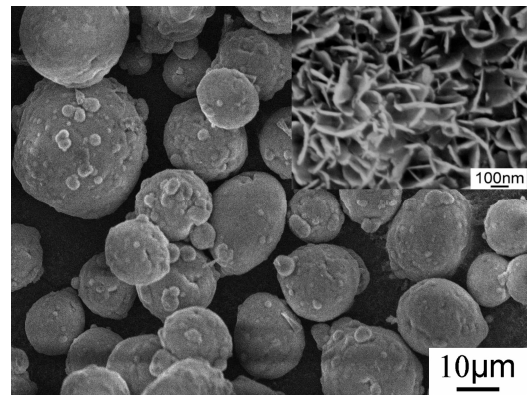
Figure 4. SEM image of Al-20Si@Al(OH) 3 .